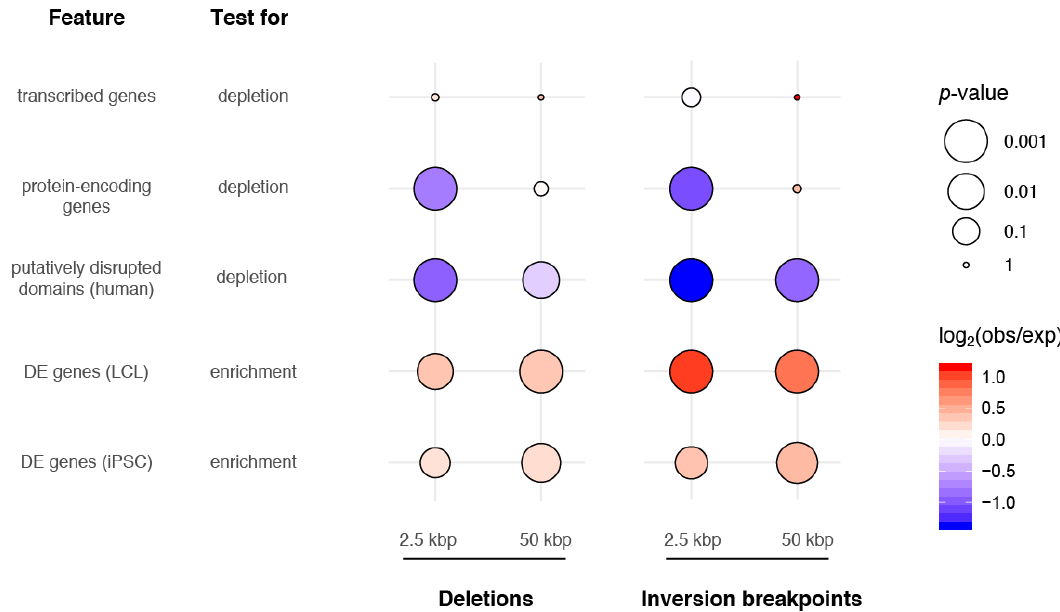
Figure 3. Enrichment and depletion tests of SVs with genomic features. Both deletions and duplications were tested within 2.5 kbp (resolution of the SV calls) and 50 kbp. All annotated genes (GENCODE v27) and protein-encoding genes were tested for depletion of SVs (top two rows) via permutation testing. Human TADs from the LCL GM12878 were tested for depletion of putatively disrupting SVs (i.e., SVs generating PDTs, third row). Human–chimpanzee DE genes from LCLs and iPSCs were also tested for enrichment in SVs via permutation testing (fourth and fifth rows). Circles are sized proportionally to the negative log of the empirical p -values and colored according to the strength of enrichment or depletion, represented by the log ratio of observed (obs; number of features intersecting SVs) and expected (exp; mean number of features intersecting 1000 permuted coordinate sets) counts.